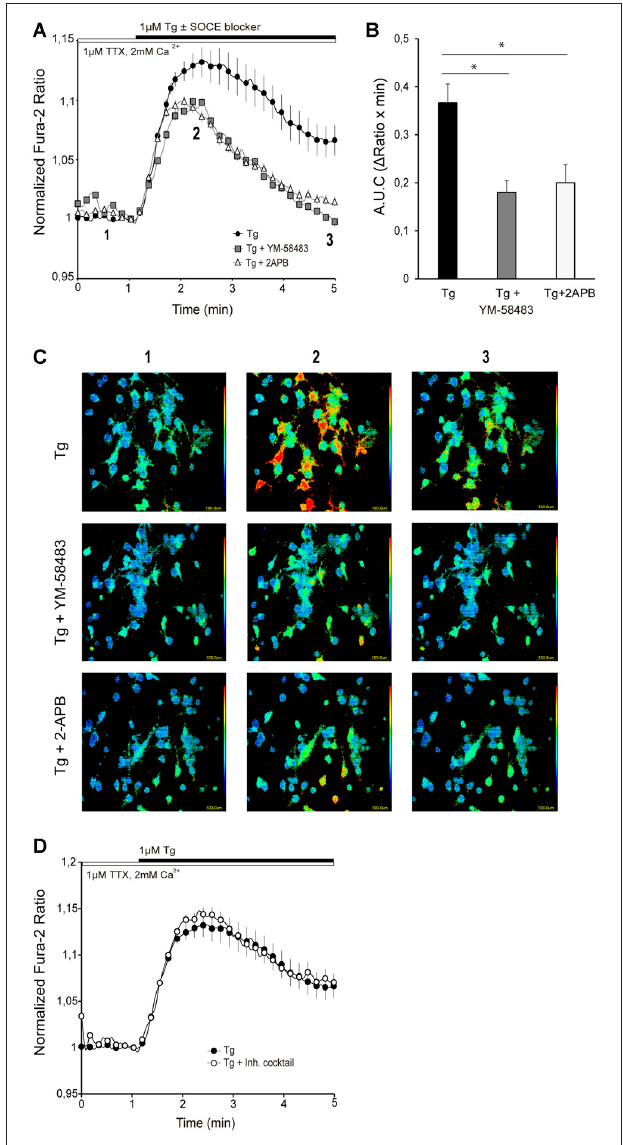
FIGURE 1 | Store-operated calcium entry (SOCE) activity in primary cortical neurons. (A) Fura-2 [Ca 2 + ] i signals in cortical neurons in HCSS medium containing 2 mM CaCl 2 and 1 µ M tetrodotoxin (TTX), upon addition of 1 µ M thapsigargin (Tg) ± 10 µ M YM-58483 or 50 µ M (2-Aminoethoxydiphenyl borate (2-APB) were indicated. The numbers refer to the frames reported in the (C) . (B) Quantification of area under SOCE curve (A.U.C, ∆ Ratio · min). Data were obtained from three independent experiments ( n = 3), and in each one a total of 25–30 cells were analyzed. (C) Representative color-coded Fura-2 [Ca 2 + ] i ratio images from basal situation (1), immediately after Tg ± SOCE blockers addition (2), and the end of the measurement. Pseudo-color ratio images were obtained using Aquacosmos 2.5 software (Hamamatsu). (D) Fura-2 [Ca 2 + ] i signals in cortical neurons in HCSS medium containing 2 mM CaCl 2 and 1 µ M TTX ± inhibitory cocktail (10 µ M CNQX (6-cyano-7-nitroquinoxaline-2,3-dione), 10 µ M MK-801, 5 µ M MPEP, 50 µ M NiCl 2 ), upon addition of 1 µ M Tg. Data were obtained from three independent experiments ( n = 3), and in each one a total of 25–30 cells were analyzed. All data are normalized to the initial values and are expressed as mean ± SEM. Means were compared using one-way ANOVA, ∗ p < 0.05, post hoc Bonferroni